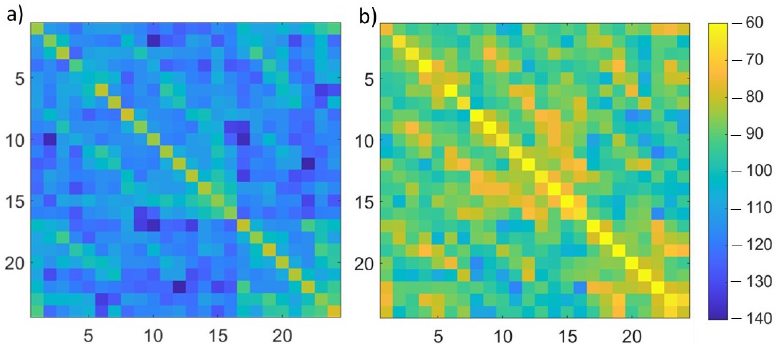
Figure 10. Difference between the scattering parameters for Systems A ( a ) and B ( b ) with respect to the nominal system, dB